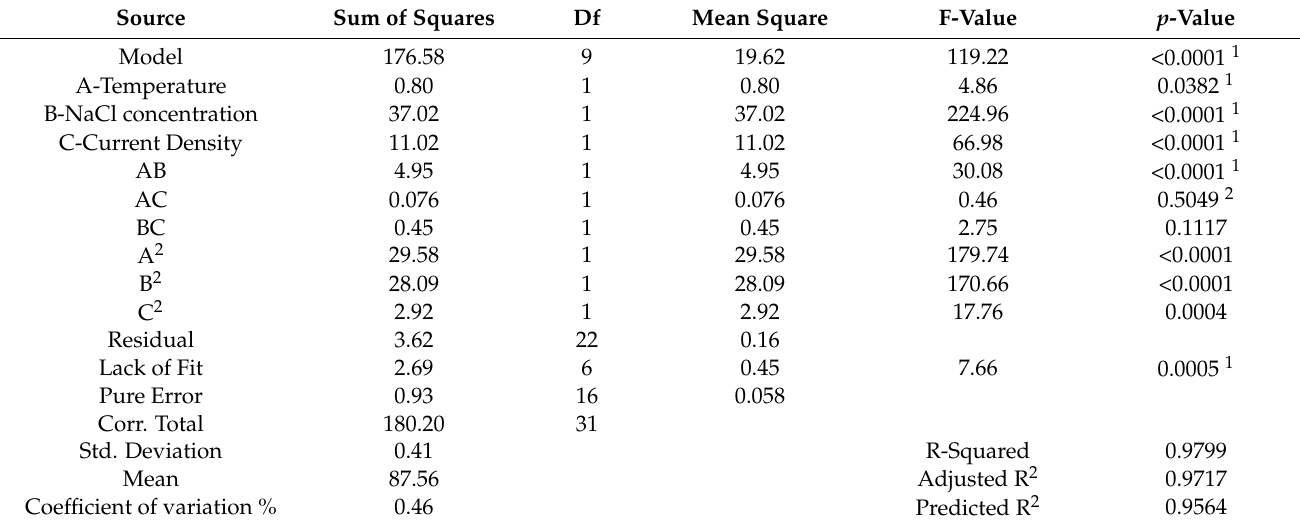
Table 3. Analysis of variation (ANOVA) of the quadratic model.